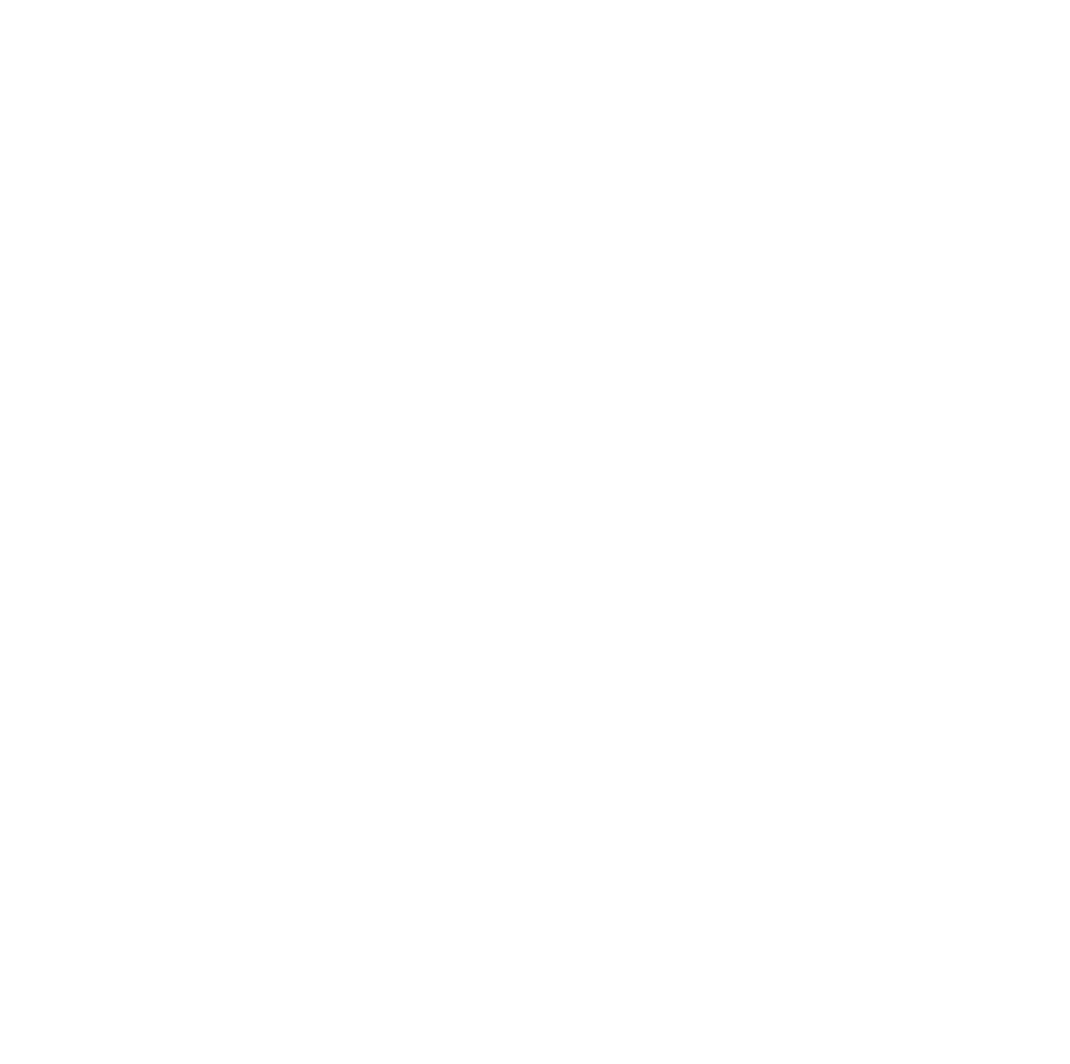
Figure 10. Plausible reaction